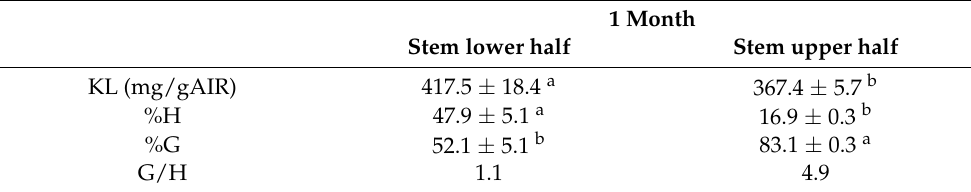
Table 2. Lignin content and monomeric composition in seedlings of radiata pine exposed to 1 month of